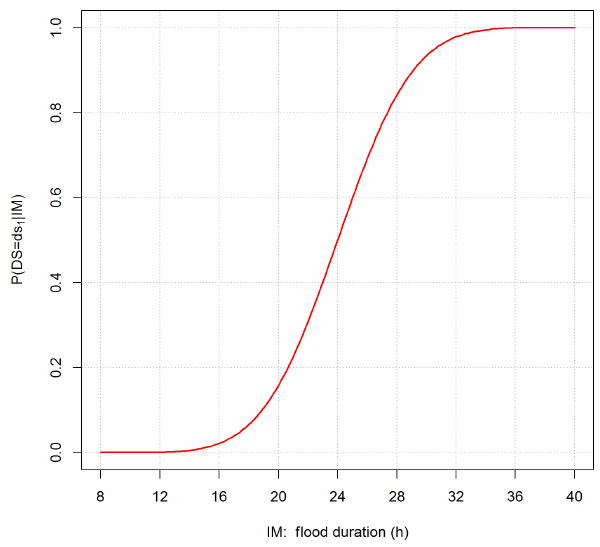
Figure 1. Fragility function for internal plaster. Here, the intensity measure of flood hazard IM is given by flood